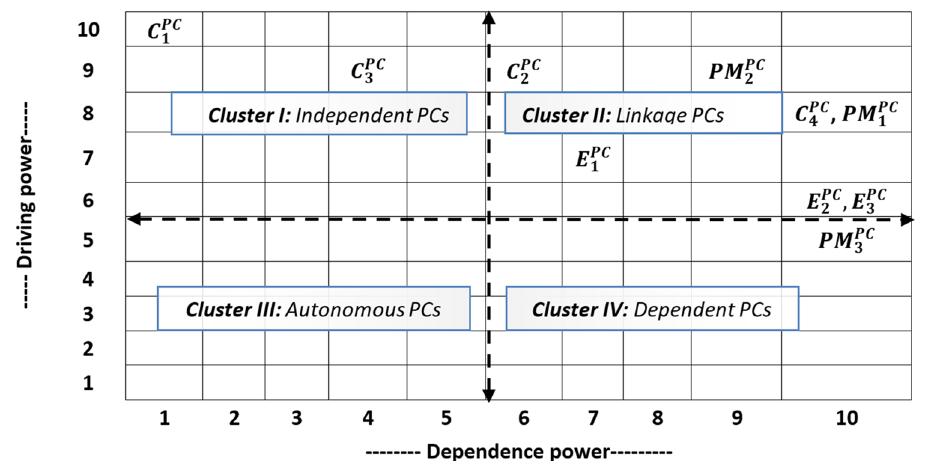
Fig. 6 MICMAC analysis. A graphical presentation of the procurement challenges based on their driving and dependence powers found in MICMAC